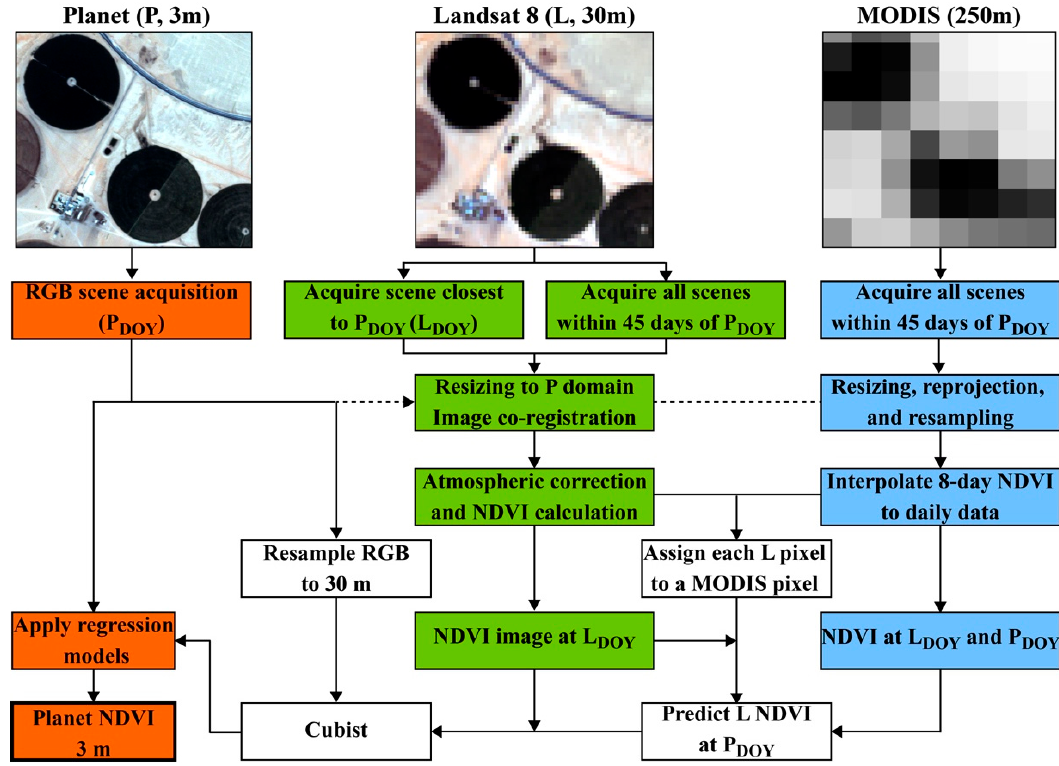
Figure 1. Overview of the multi-sensor processing framework used for converting the Planet (P) RGB information into Landsat-8 (L) consistent estimates of atmospherically corrected NDVI. The integration of MODIS 250 data is needed to correct for changes in cover conditions occurring between the Planet and Landsat scene acquisitions when they are more than ~4 days apart. Specific details are provided in Section 2.3.